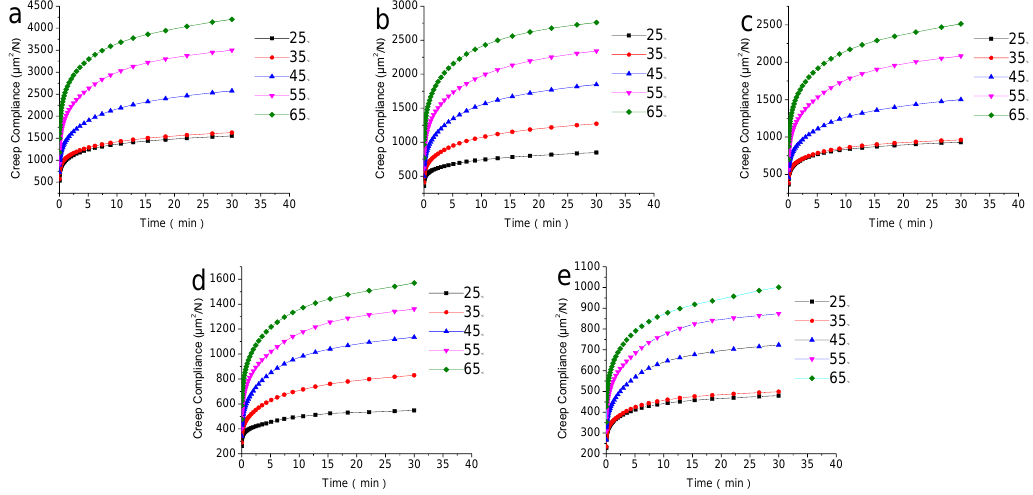
Figure 4. Effects of temperature on creep behavior of different composites: ( a ) biochar-30 wt %; ( b ) biochar-40 wt %; ( c ) biochar-50 wt %; ( d ) biochar-60 wt % and ( e ) biochar-70 wt %.